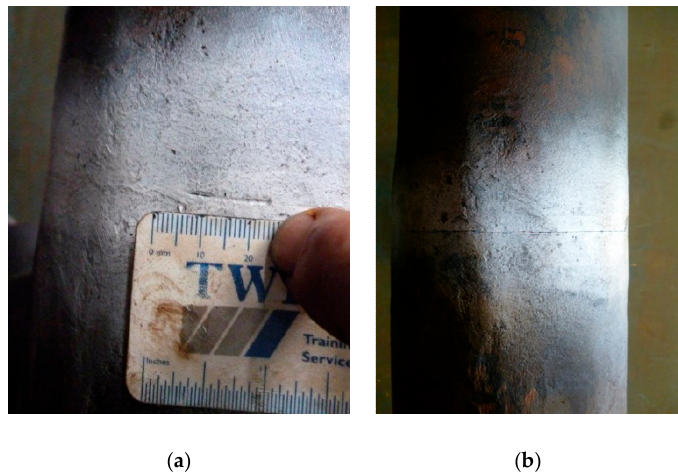
Figure 7. Crack indications after magnetic particle inspection (MPI) at ( a ) 4,333,424 cycles (5 mm) and ( b ) 4,923,552 cycles (120 mm).